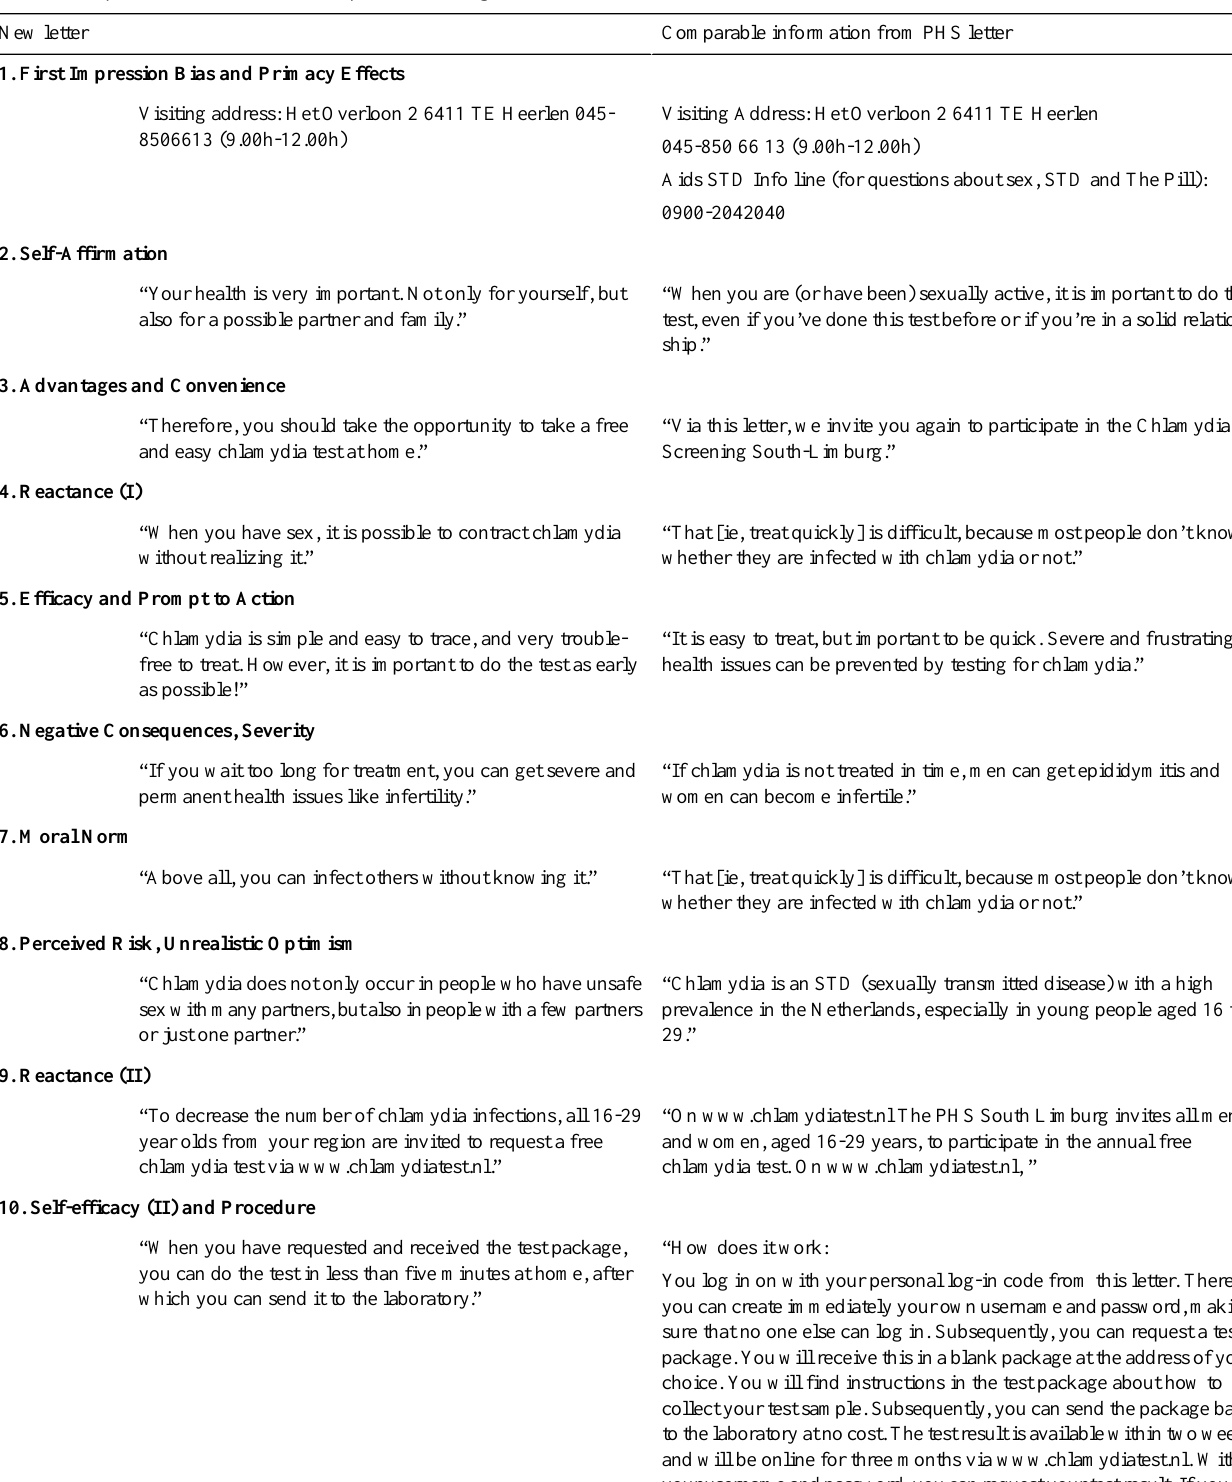
Table 1. Adaptation of the new letter compared to the original PHS letter.